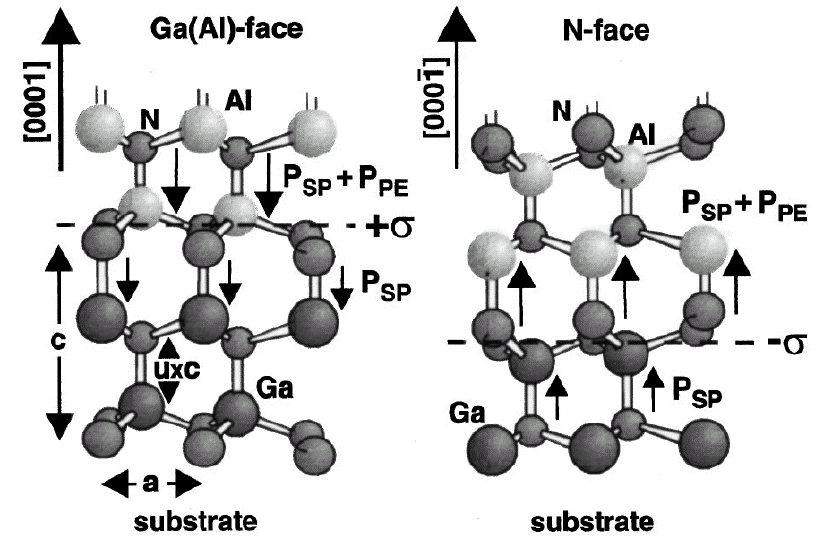
Figure 1. Piezoelectric(PE) and spontaneous polarization(SP) effects in Ga(Al) or N-face AlGaN/GaN heterostructures (after refs 5 and